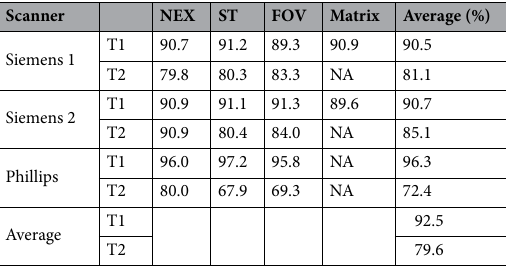
Table 1. The percentages of radiomics features for the MRI phantom within the established patient population bounds (mean ± 2 SDs). Siemens 1 and 2 represent two repeated scans in a Siemens scanner; ST slice thickness, FOV field of view, NA not available.